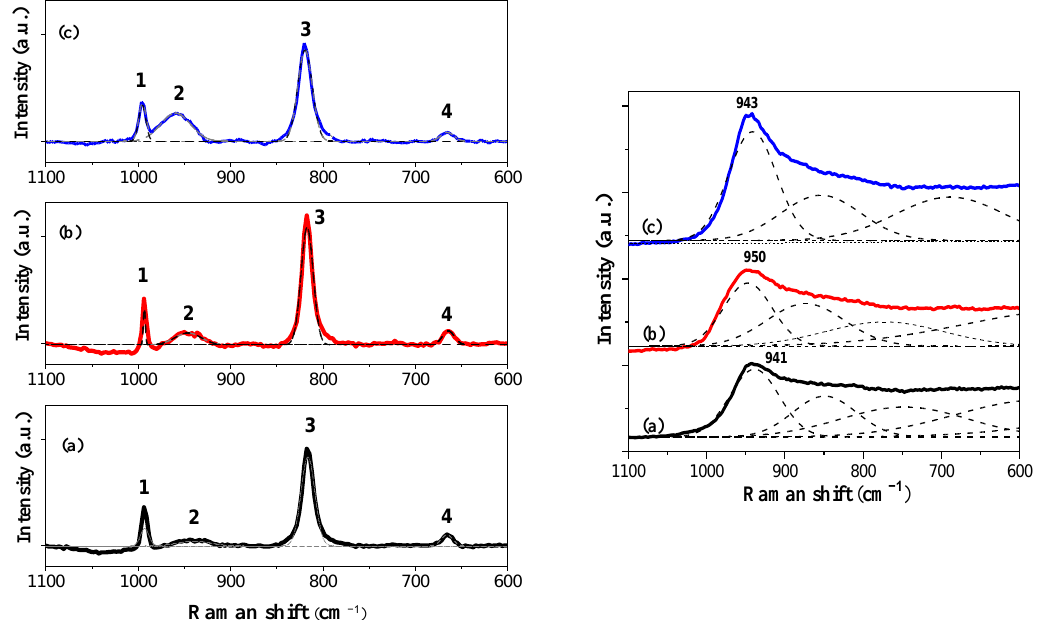
Figure 4. Raman Spectra for the Mo/AT2 ( left ) and CoMo/AT2 ( rigth ) catalysts by using different Mo loadings: ( a ) 10, ( b ) 12 and ( c ) 15 wt.%.